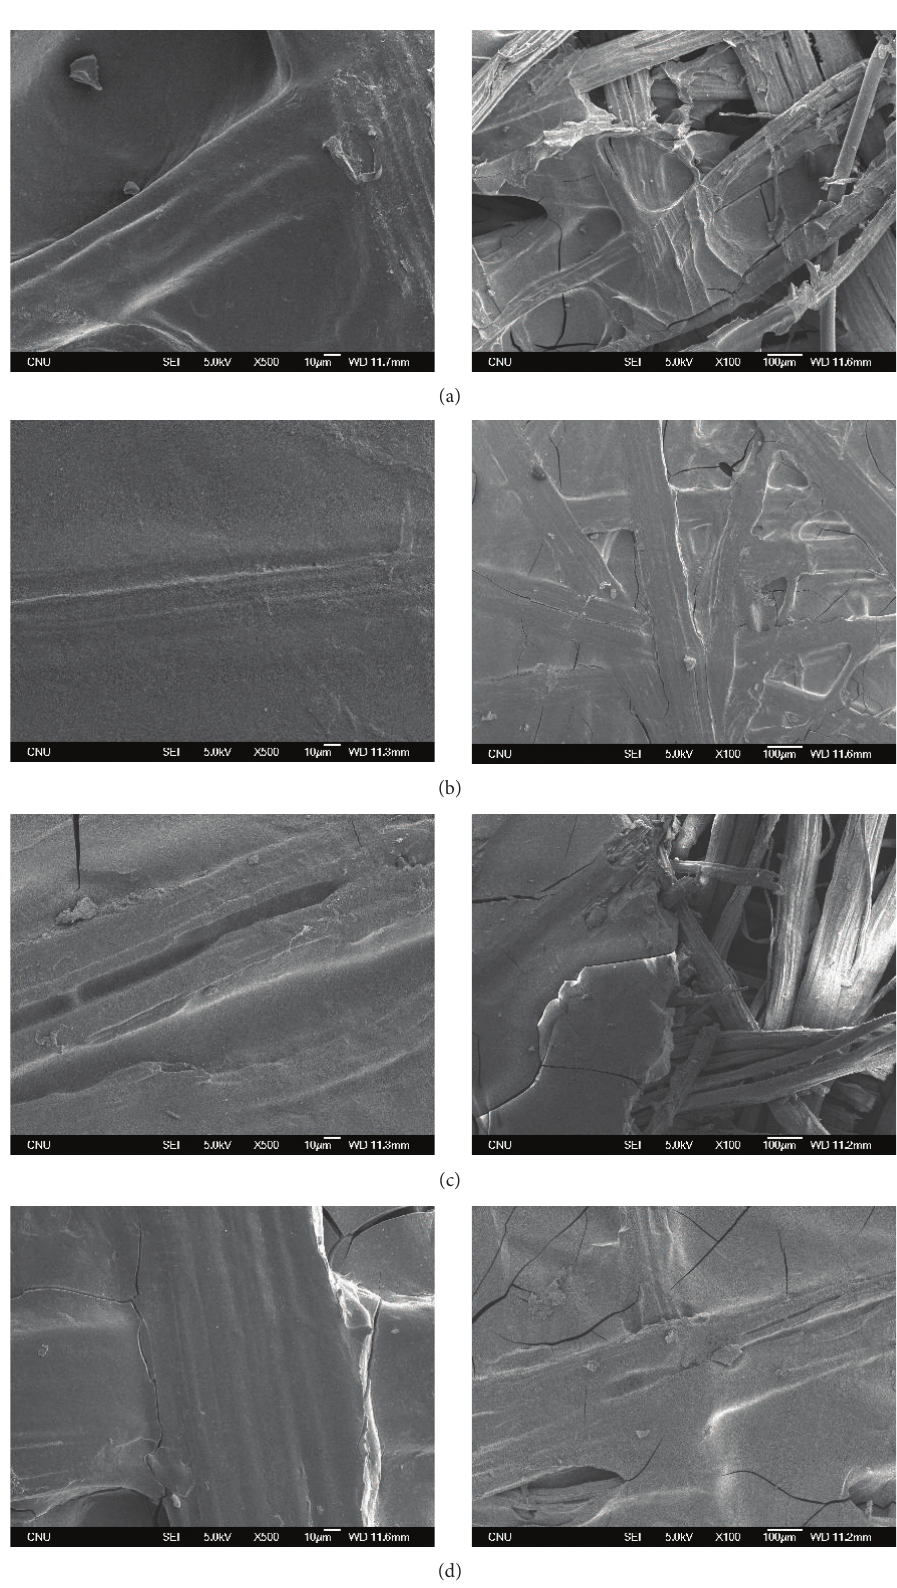
Figure 17: Surfaces (left, × 500) and fracture surfaces (right, × 100) of the kenaf/SPI-PVA composites with GA content: (a) 0wt%, (b) 8wt%, (c) 16wt%, and (d) 25